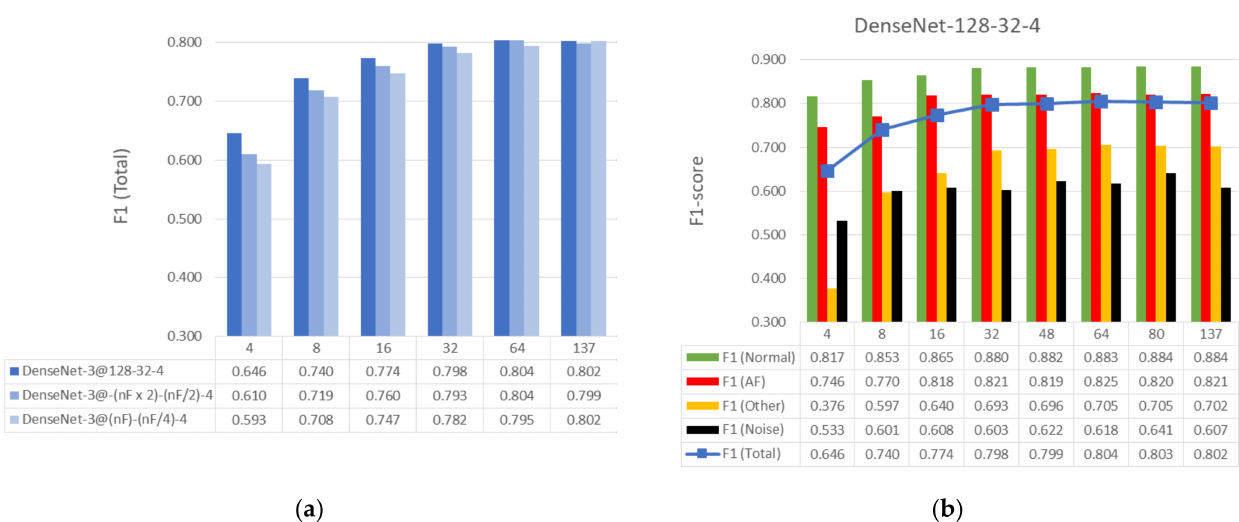
Figure 8. Performance evaluation in case of feature reduction based on Global Weights Importance rank for: ( a ) Different architectures of DenseNet; ( b ) DenseNet-3@128-32-4 performance for different